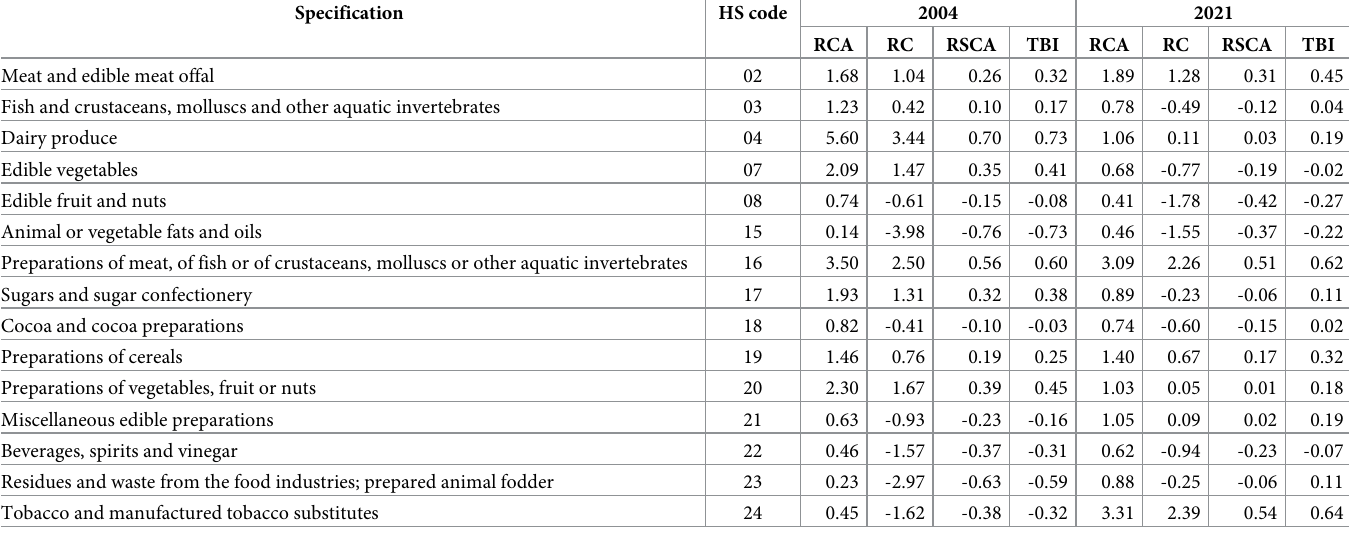
Table 5. Comparative advantages of the polish agri-food sector in trade with the other EU countries in 2004 and 2021.